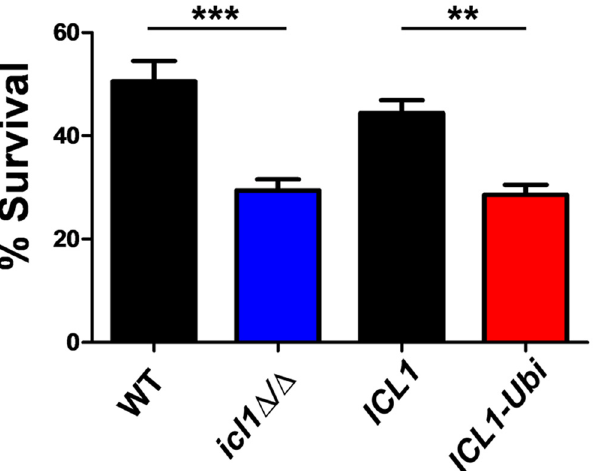
Fig 4. Metabolic flexibility in C . albicans promotes resistance to macrophage killing. Survival of C . albicans strains following co-incubation with J774.1 macrophages for 48 h: WT, SC5314; icl1 Δ / Δ , DCY65; ICL1 , DCY75 ( ICL1-Myc 3 -NAT1 ); ICL1-Ubi , DCY82 ( ICL1-Ubi-Myc 3 -NAT1 ) (S2 Table in the supplementary information). Data represent three independent biological experiments performed in technical triplicate (mean values plus standard error of the mean (SEM)). The data were analysed using one-way ANOVA with Tukey ’ s post-hoc test: * , P (cid:1) 0.05; ** , P (cid:1) 0.01; *** , P (cid:1) 0.001.